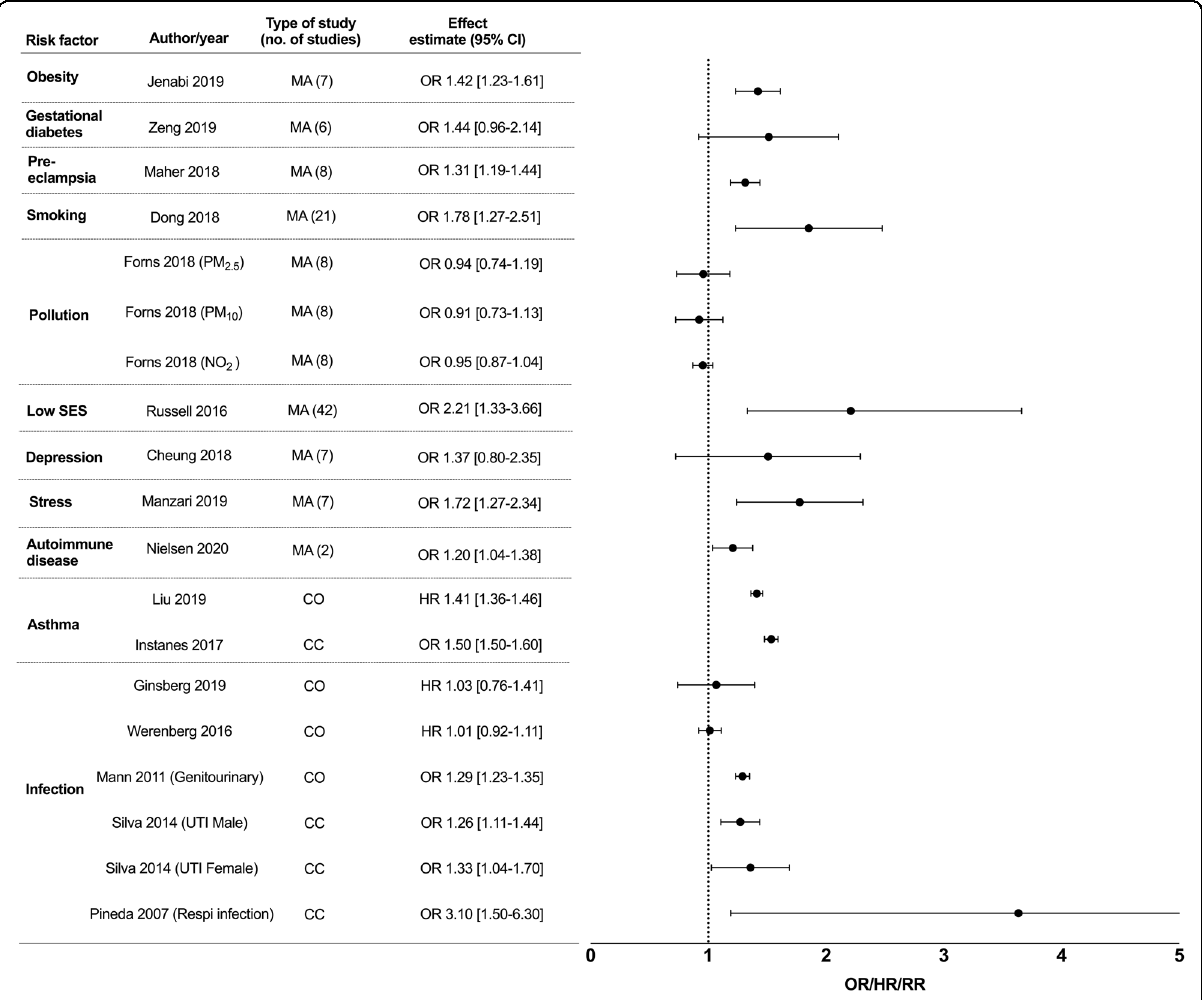
Fig. 4 Epidemiological studies of maternal in fl ammatory states and attention de fi cit hyperactivity disorder (ADHD) in offspring. Maternal in fl ammatory states included in Y-axis (with columns including author names, year of publication, type of study, number of individual studies included in meta-analysis, effect estimate with 95% con fi dence interval (CI)). Effect estimate with 95% con fi dence interval reported in X-axis. In this forest plot, we only included the largest meta-analysis that examined the association of individual maternal in fl ammatory state and ADHD in offspring. For full data see Supplementary Fig. 2. SES = socioeconomic status, PM 2.5 = particulate matter (particles with diameter of 2.5 micrometers or less), PM 10 = particulate matter (particles with diameter of 10 micrometers or less), NO 2 = nitrogen dioxide, UTI = urinary tract infection, Respi infection = respiratory infection, MA = meta-analysis, CC = case-control, CO = cohort, RR = relative risk, OR = odds ratio, HR = hazard